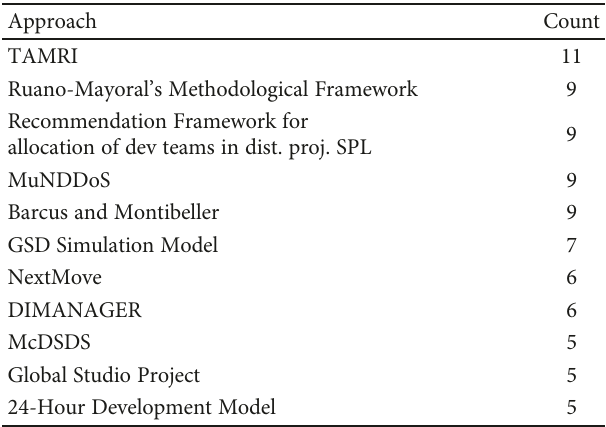
Table 6: Total of positively answered